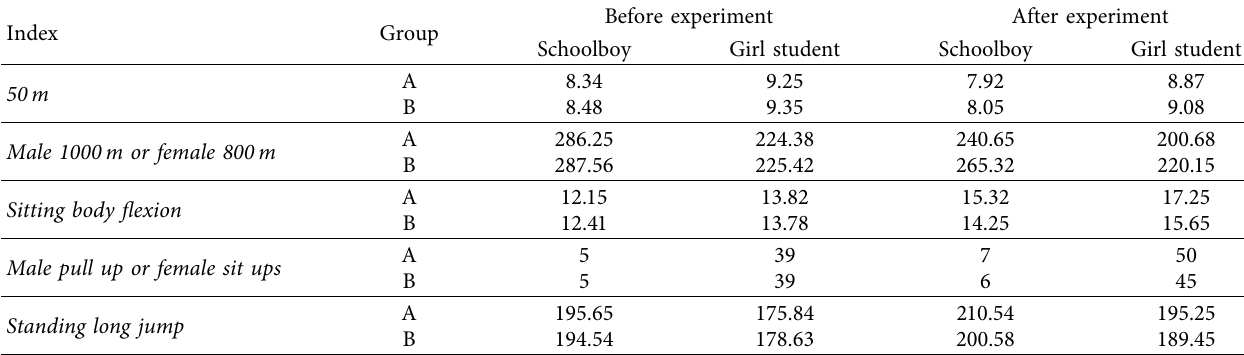
Table 5: Comparison of average data of various indicators of students’ physical fitness.